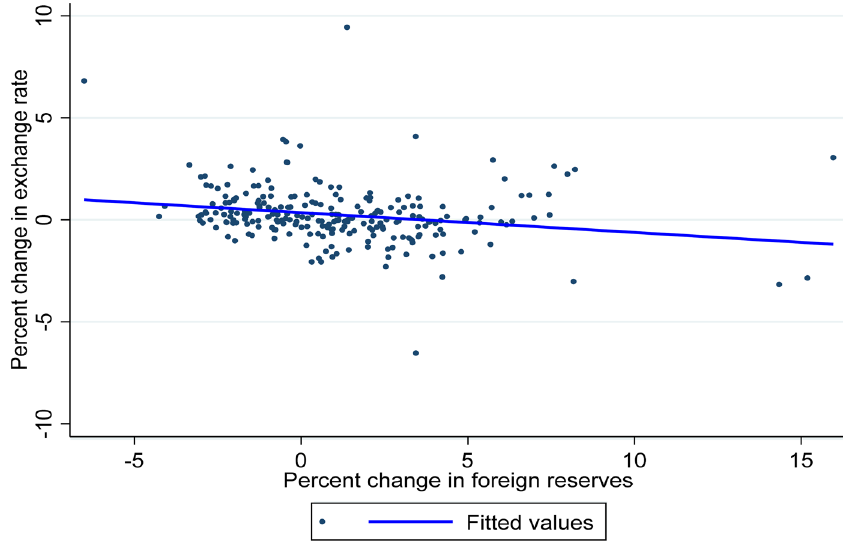
Fig. 1 Exchange rate versus foreign reserves (partial